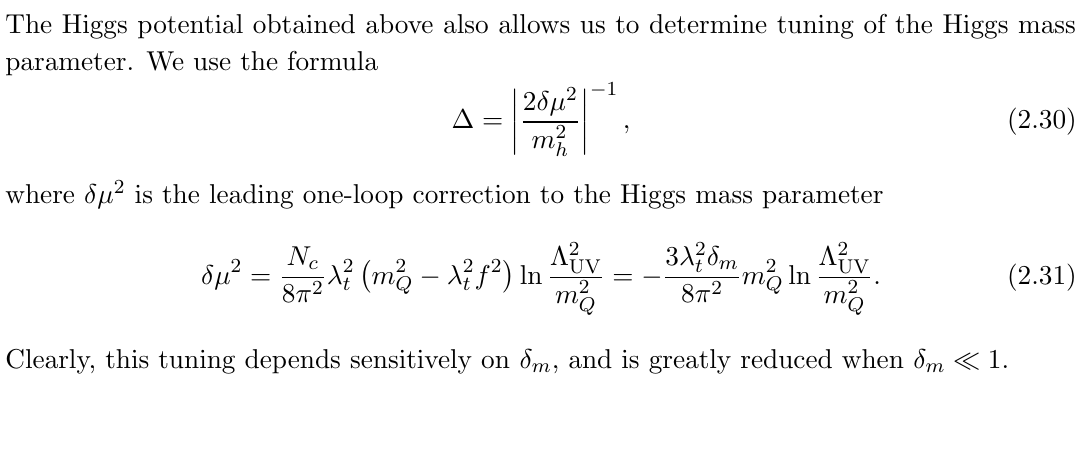
Figure 2 . The quartic couplings involving the DM (cid:12)eld (cid:31) as a function of r Q = m 2 neglected all terms of order (cid:14) m